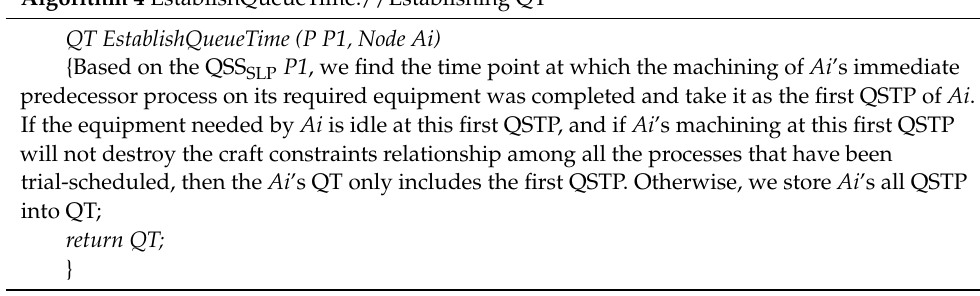
Algorithm 4 EstablishQueueTime.//Establishing